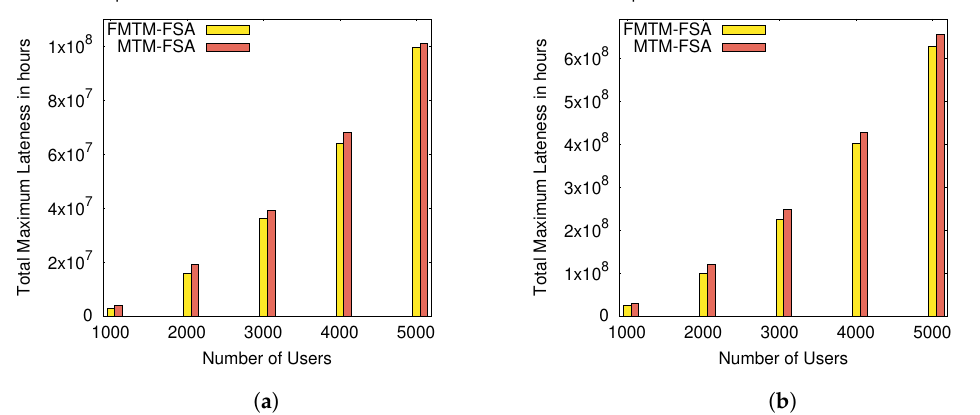
Figure 12. Comparison of FMTM-FSA and MTM-FSA based on lateness for the ND and RD cases: ( a ) comparing FMTM-FSA and MTM-FSA (ND case) and ( b ) comparing FMTM-FSA and MTM-FSA (RD